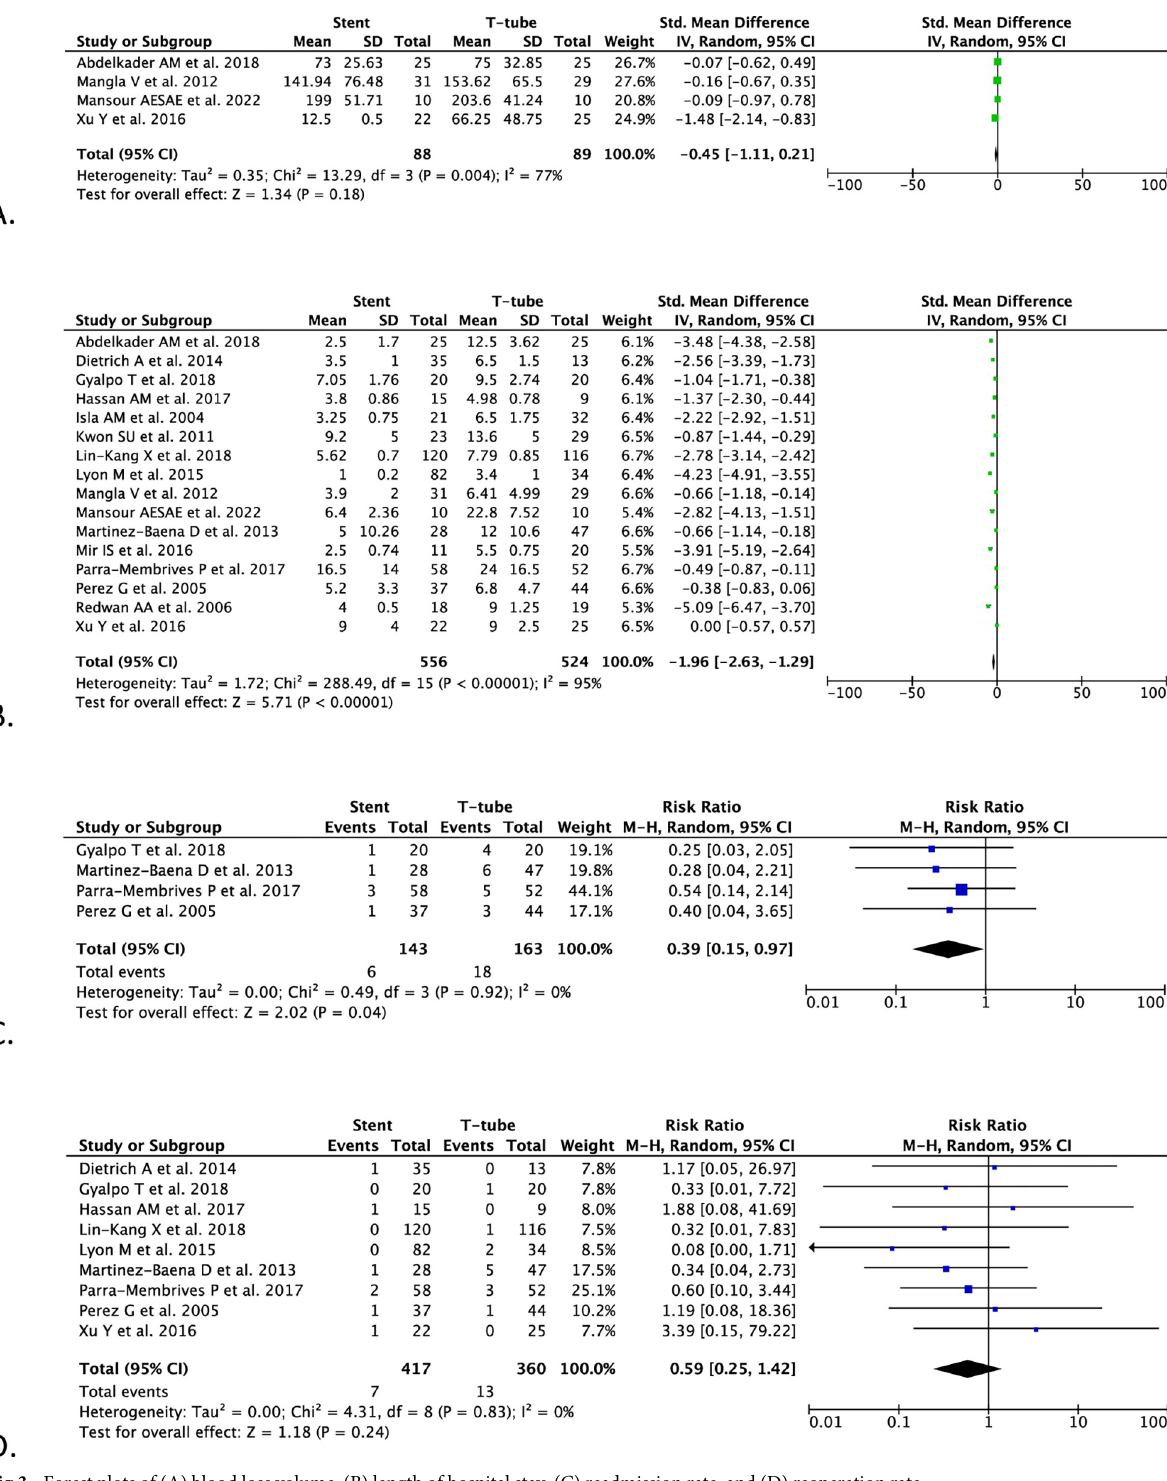
PLOS ONE | https://doi.org/10.1371/journal.pone.0280755 January 20, 2023 10 /